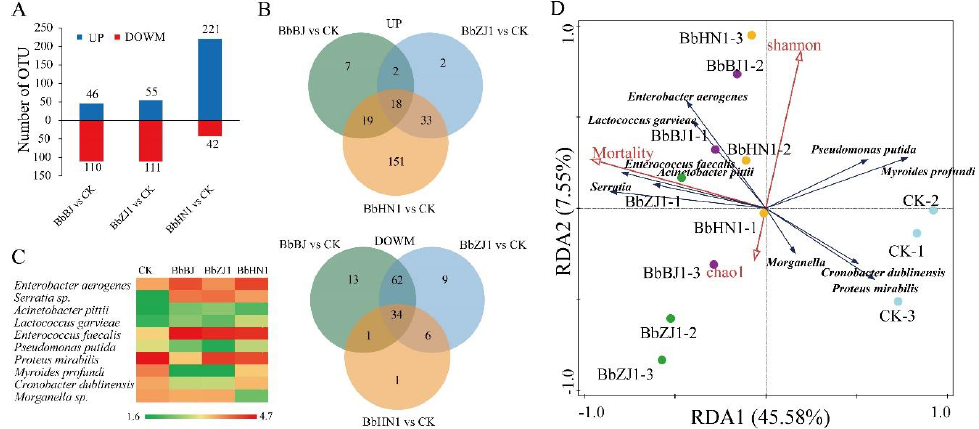
Figure 4. Changes in the intestinal bacteria in migratory locusts after Beauveria bassiana infection. ( A ) The number of Operational Taxonomic Units (OTUs) whose abundance increased or decreased in migratory locusts in response to infection by each of the three fungal pathogens. ( B ) Venn diagram showing how many OTUs increased or decreased in response to infection by all three fungal strains. ( C ) A heat map of the top ten most abundant bacteria. This figure plots the number of reads of 16 s DNA of related bacteria obtained by sequencing. The data used for analysis were calculated using Log10 (X). ( D ) Redundancy analysis of L. migratoria bacterial community.